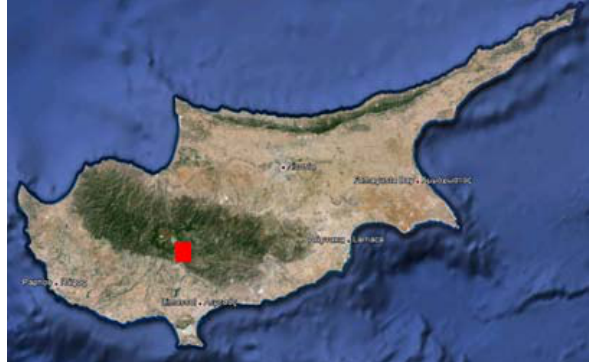
Figure 8. The AOI is located in the centre of Cyprus (Source: Google